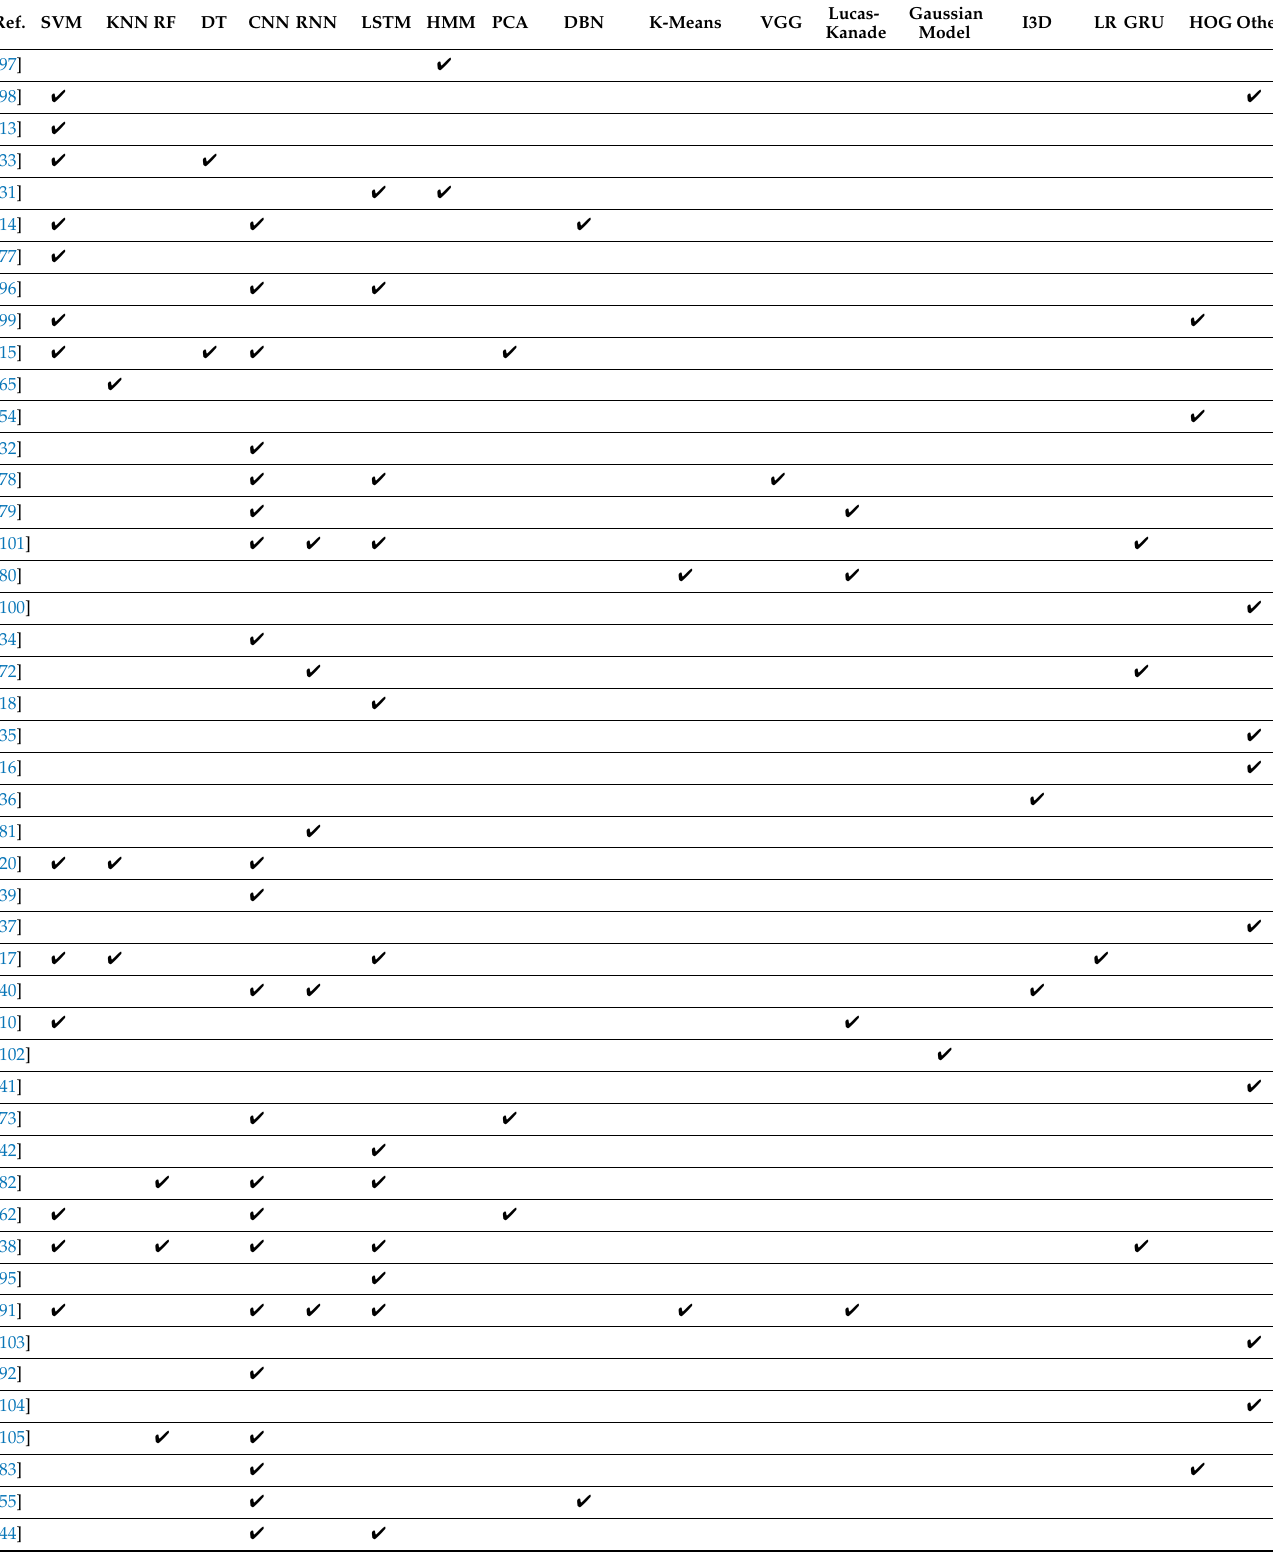
Table 9. Techniques/algorithms used in the